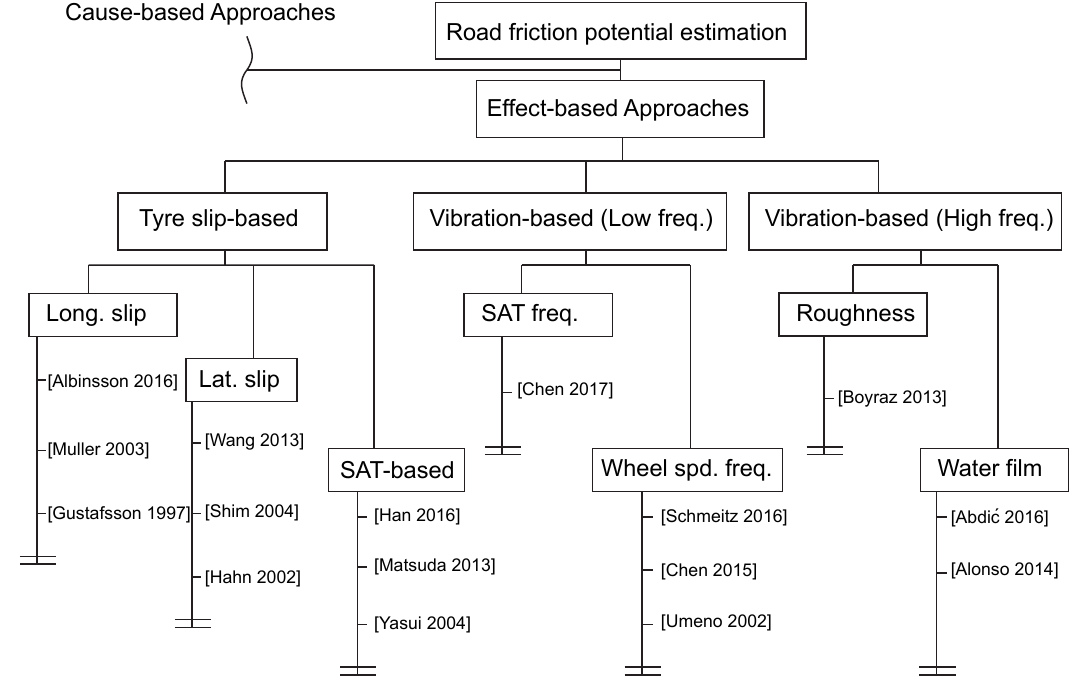
Figure 1. Overall picture of the effect-based road grip recognition approaches treated in this